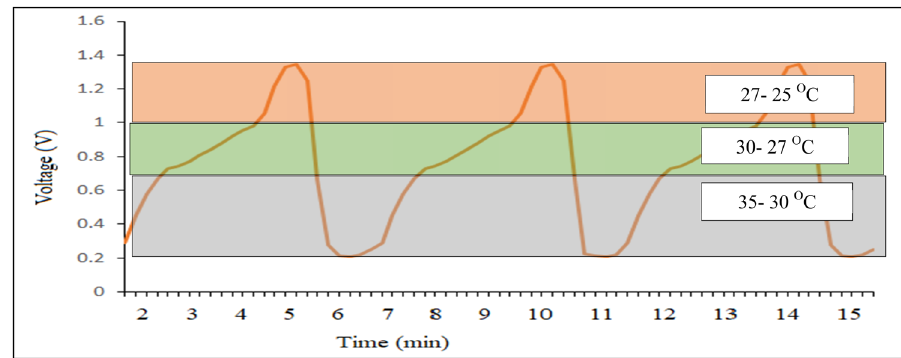
Figure 15: Half recti fi cation signal.